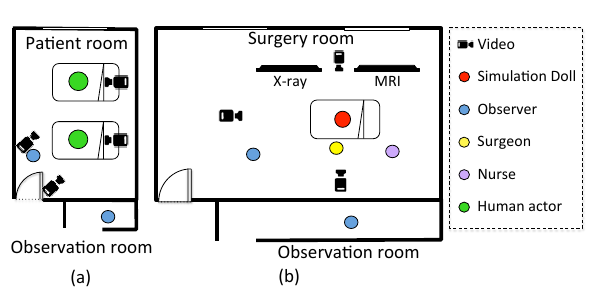
Figure 3. a) The simulation setup for the ward round